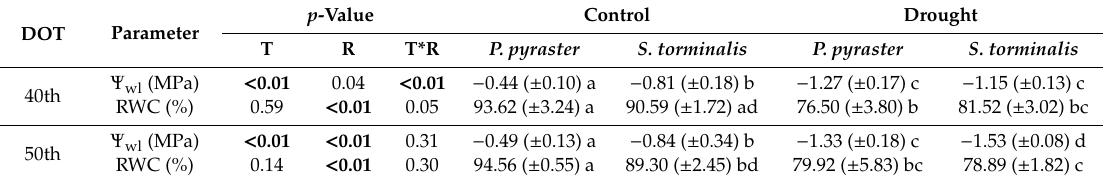
Table 4. A two-way ANOVA analysis of the measured water potential of leaf tissues ( Ψ wL ) in the pot experiment with P. pyraster and S. torminalis seedlings, comparing the e ff ects of taxon (T), drought treatment (R), and the interaction between them (T*R). Measurements were performed on 40th and 50th day of treatment (DOT). Significant di ff erences ( p < 0.05) are marked in bold. The multiple comparison of means was performed at the significance level of 0.05. Data are the mean values ± SD ( n = 9). The significant di ff erences between species and treatments are denoted by di ff erent